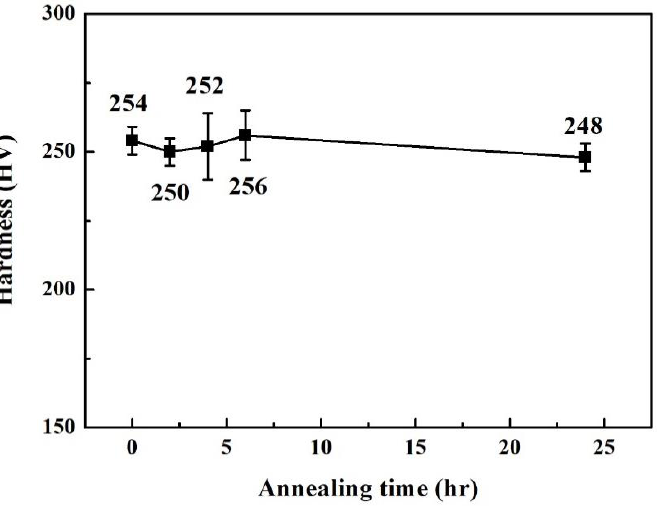
Figure 4. Plot of hardness of Cr 27 Fe 24 Co 18 Ni 26 Nb 5 alloy as a function of annealing time; the annealing temperature was 1000 ◦